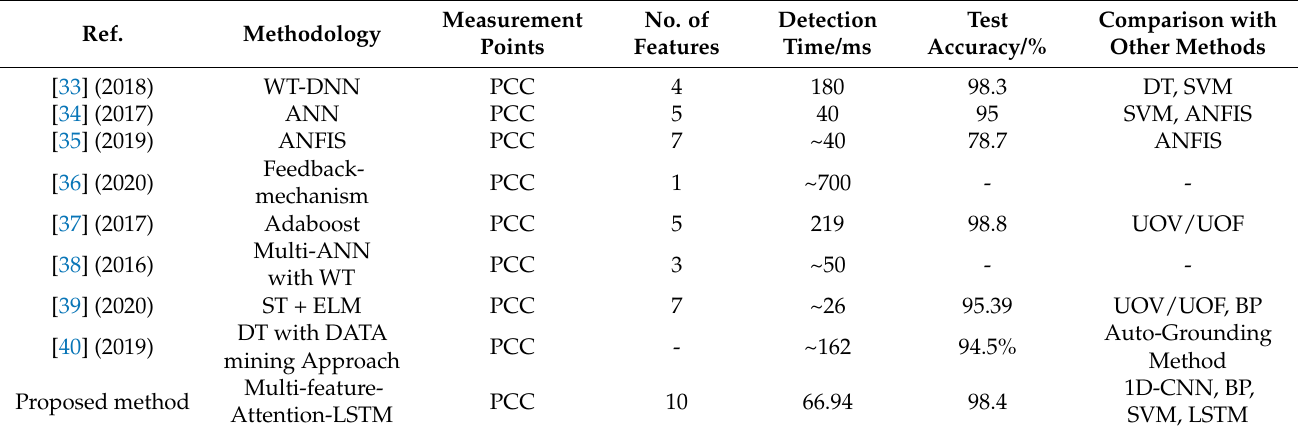
Table 5. Comparison of the detection time of the proposed method with that of methods proposed in the